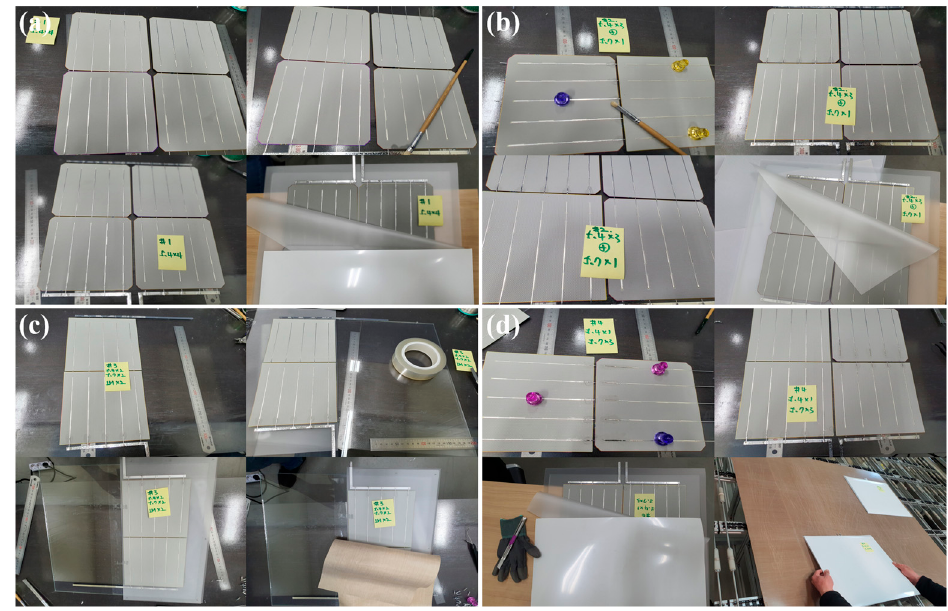
Figure 4. Process for making small range of electrical mismatch samples.